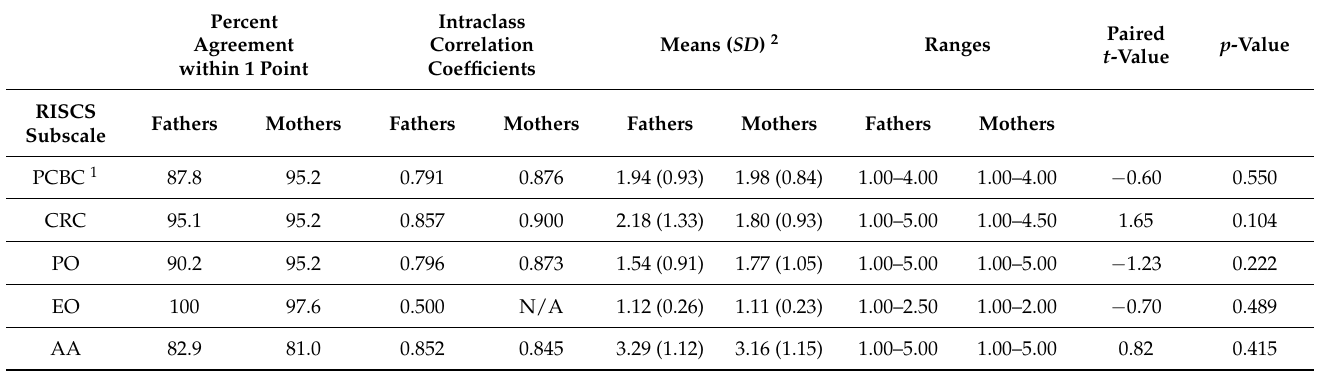
Table 1. Interrater reliability for RISCS, descriptive statistics, and mother–father